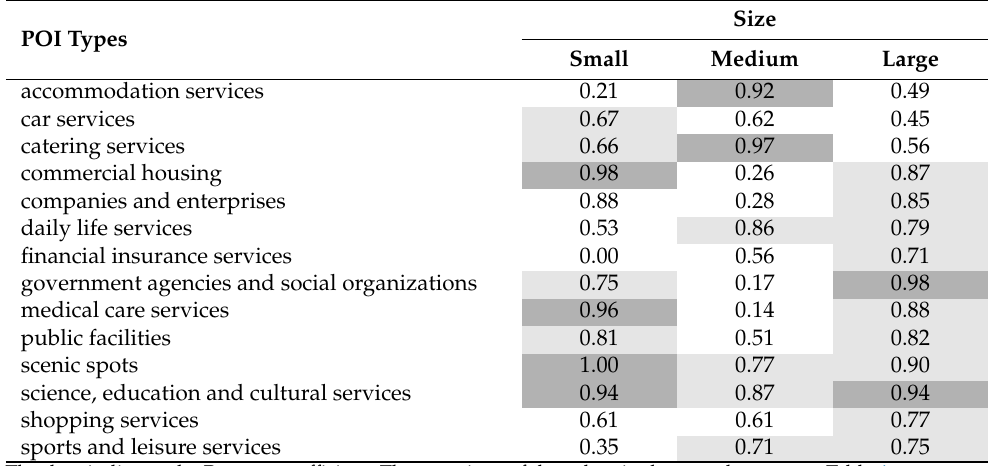
Table 5. The correlations between POIs and parking lots in different size